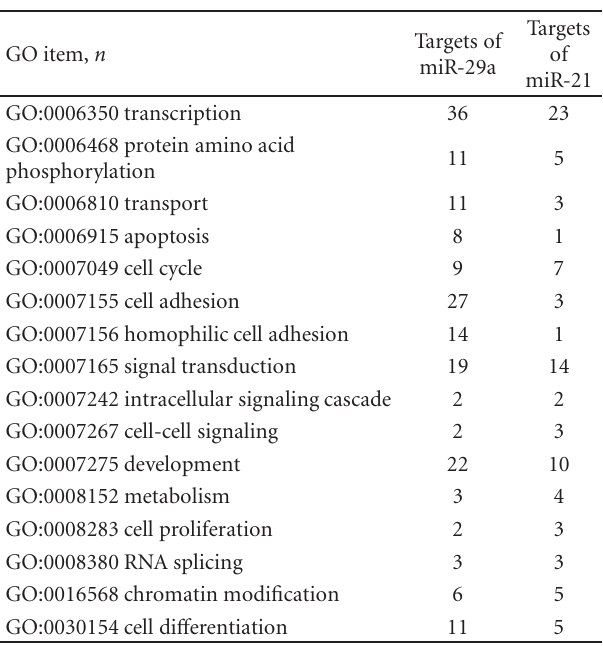
Table 3: The results of gene ontology analysis targets of di ff eren- tially expressed